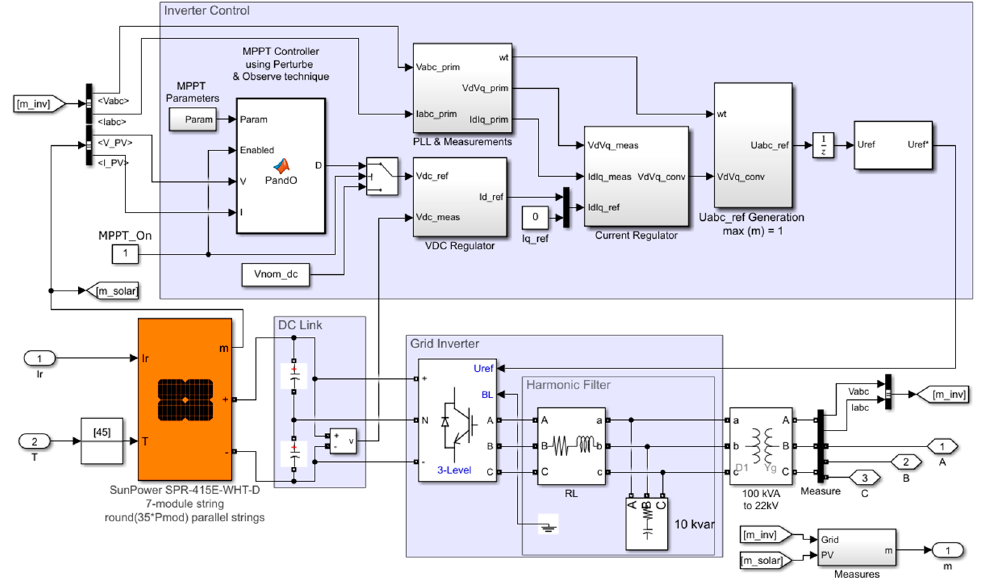
Figure 8. Schematic model of the photovoltaic station.